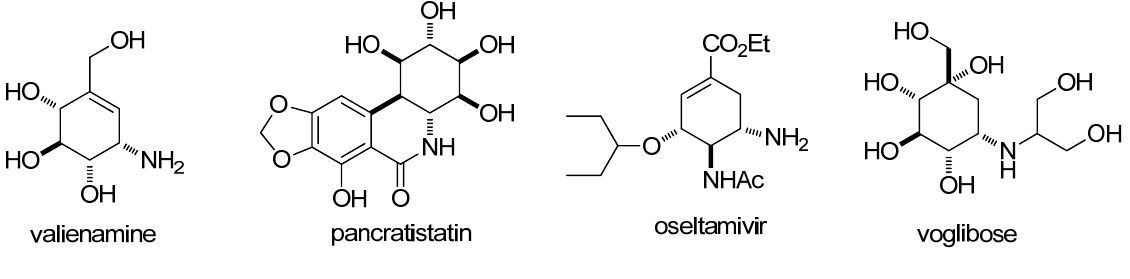
Figure 2. The previously synthesized